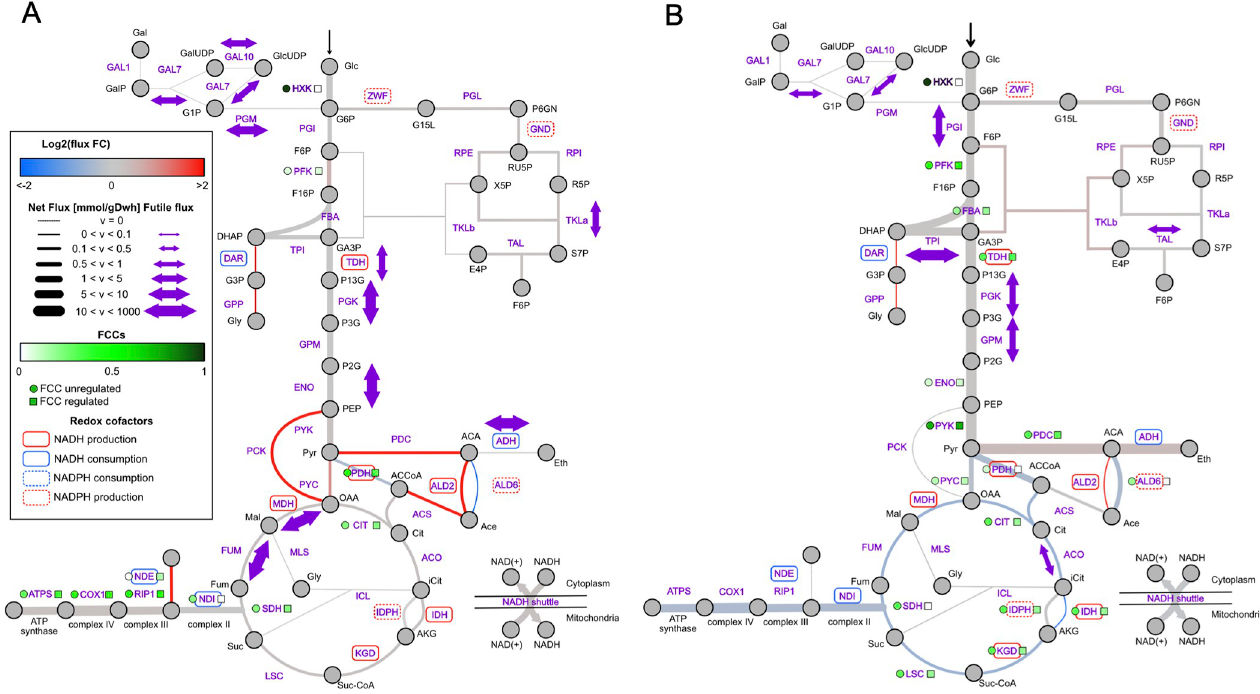
Fig 4. The core reactions in the metabolism under (A) respiration and (B) fermentation are shown. The fluxes are represented by the width of the connectors where dotted lines represent zero flux. The color of the connectors represents the change in flux from the unregulated ecModel compared to the regulated hybrid model. The FCCs are represented in the figure where the unregulated case is depicted by circles and compared to the regulated case depicted in squares.